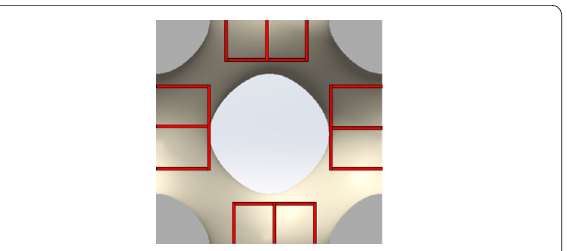
Figure 6 Eight observation areas on the surface of the bone